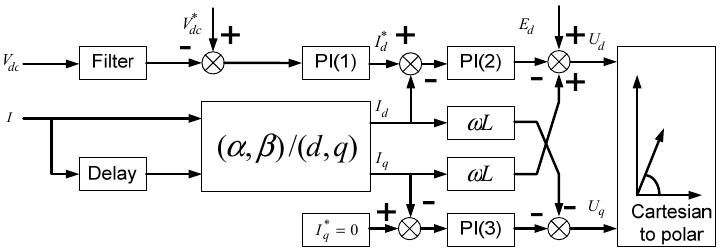
Figure 2. The input stage control